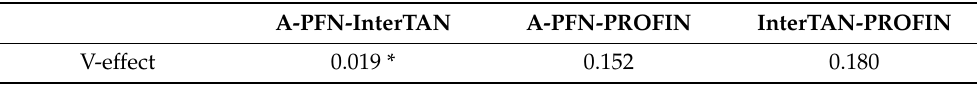
Table 7. Post hoc evaluations of the V-effect among nail subtypes. A-PFN-InterTAN A-PFN-PROFIN InterTAN-PROFIN V-effect 0.019 * 0.152